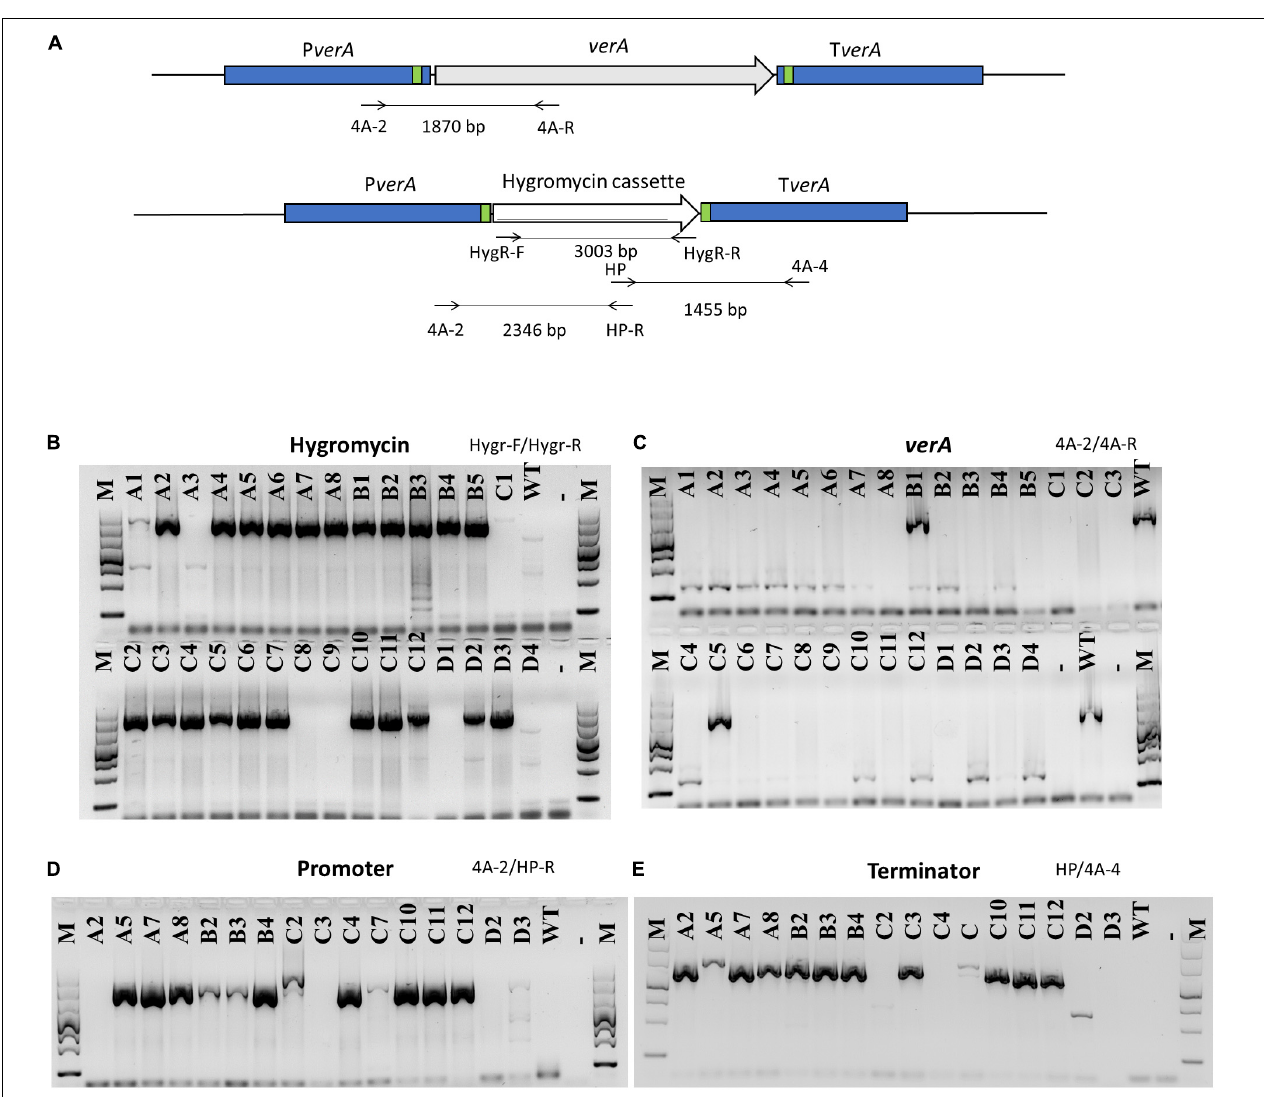
FIGURE 3 | PCR analysis of verA mutants. Schematic presentation of the verA ( cl4A ) locus in the wild-type and deletion mutants; homology sequences (50 bp) are indicated in green, and primers used are marked by arrows (A) . Amplification of hygromycin resistance cassette (B) and verA gene (C) ; confirmation of orientation of inserted repair DNA (D,E) ; M, GelPilot Wide Range Ladder; WT, wild-type P. polonicum X6; A–D, deletion mutants for verA ; –, negative control (PCR mix without